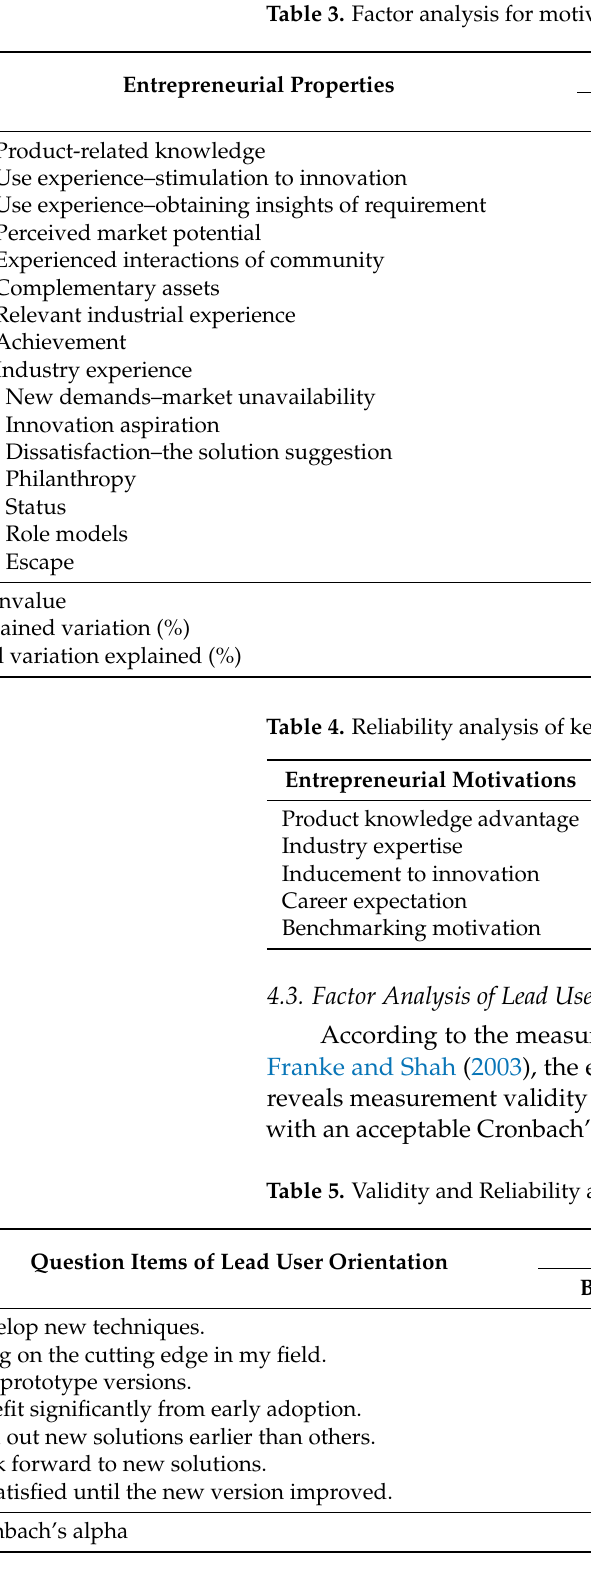
Table 3. Factor analysis for motivations of user entrepreneurs after Varimax rotation.